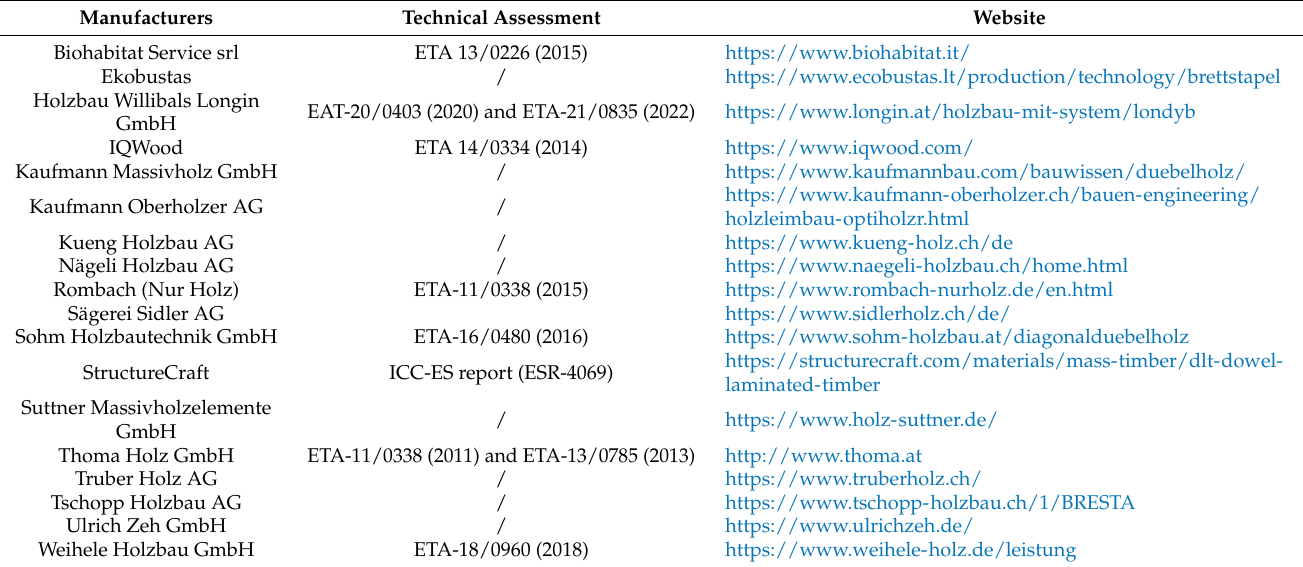
Table 3. Existing DLT manufacturers,